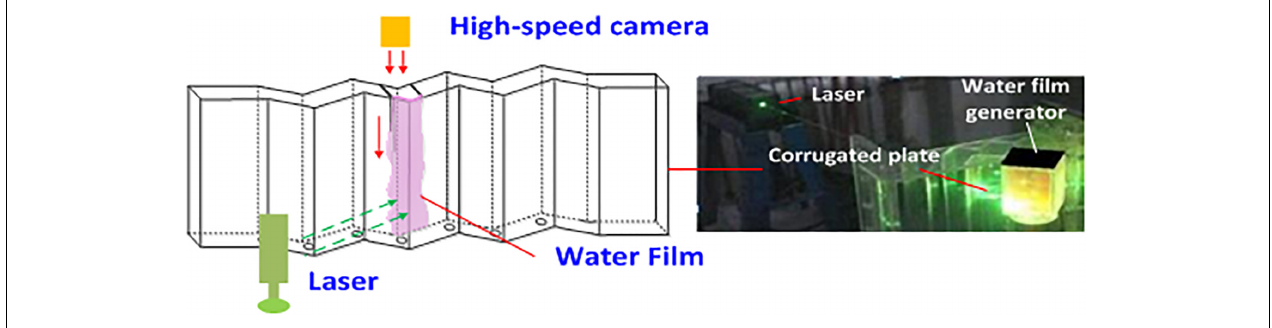
FIGURE 3 | PLIF method for liquid film thickness measurement.